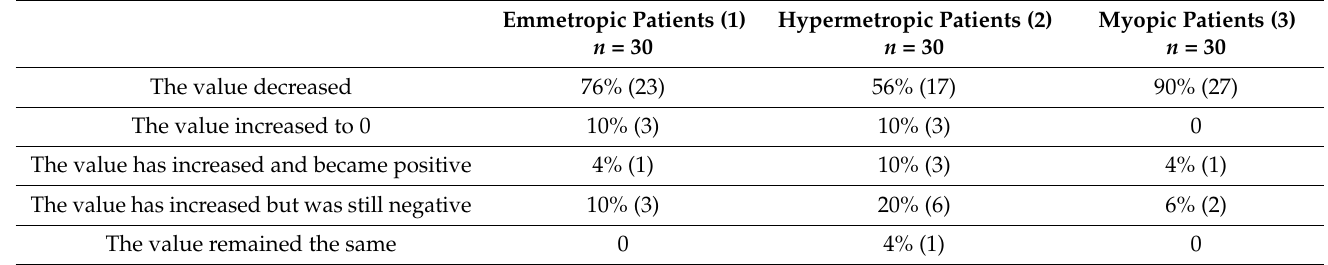
Table 2. The differences in the planned spherical equivalents against the spherical equivalents measured in the third month post-surgery (number of people).